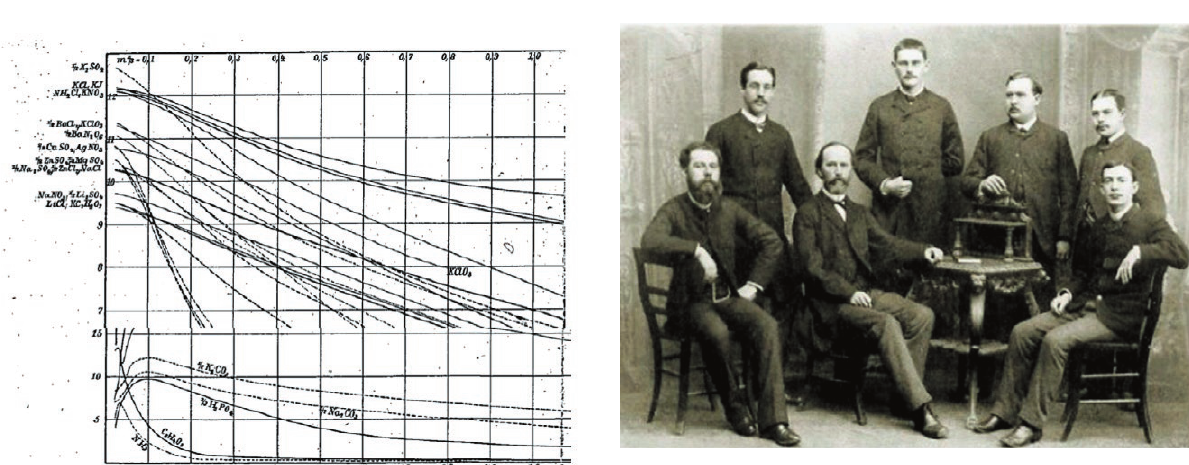
Figure 6. Photograph of Friedrich Kohlrausch´s research group at the Physical Institute of the University in Würzburg in winter semes- ter 1886/87, taken in February 1887. Standing from left, Adolf